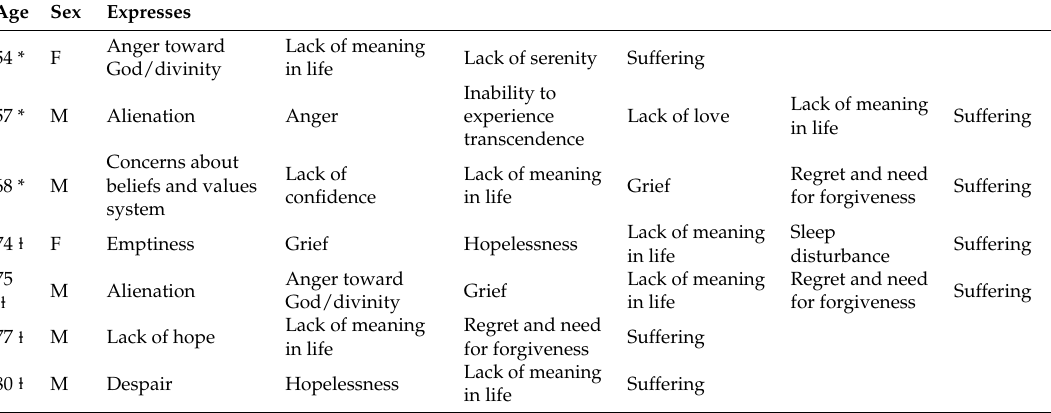
Table 1. Defining characteristics of spiritual distress in palliative